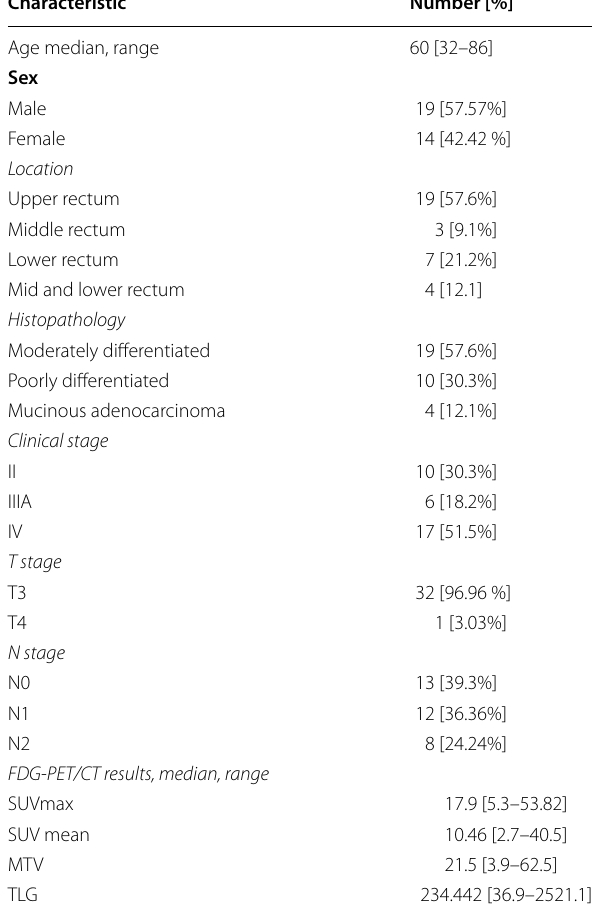
Table 1 Patient and tumor